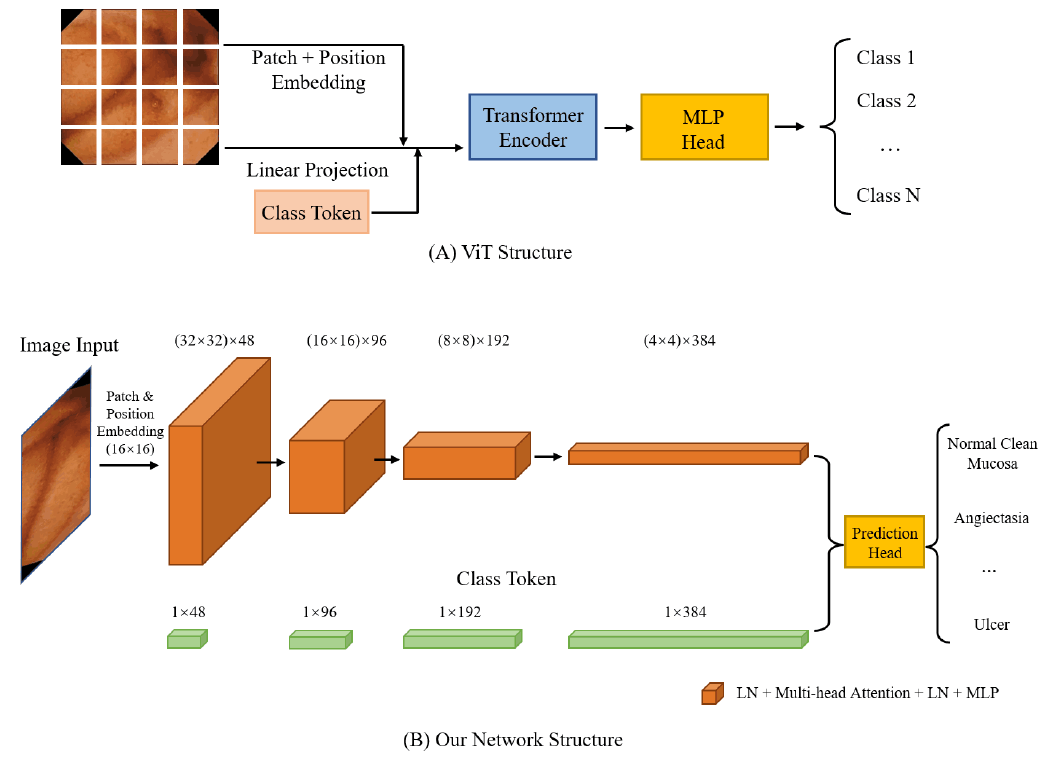
Figure 2. The neural network architecture. ( A ) An original ViT structure for the classification task. The image is first converted into flattened patches through Patch Embedding and Position Embedding, then processed by the Transformer Encoder. The prediction result is obtained after the MLP Head. ( B ) The spatial structure of the original ViT keeps unchanged, while we adopt a ViT structure with 3-step pooling. ( n × n ) × m represents a ( n 2 × m ) 2D matrix when in ViT and a ( n × n × m ) 3D matrix when conducting pooling